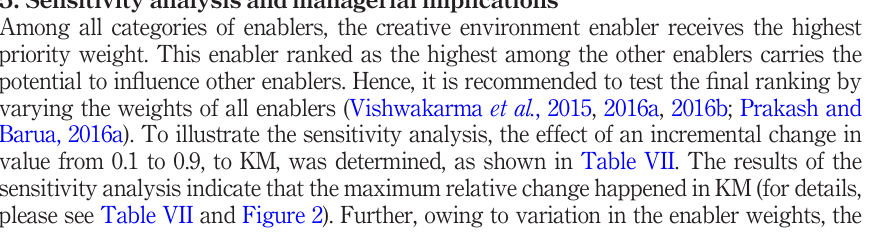
Table VII. Ranking for speci fi